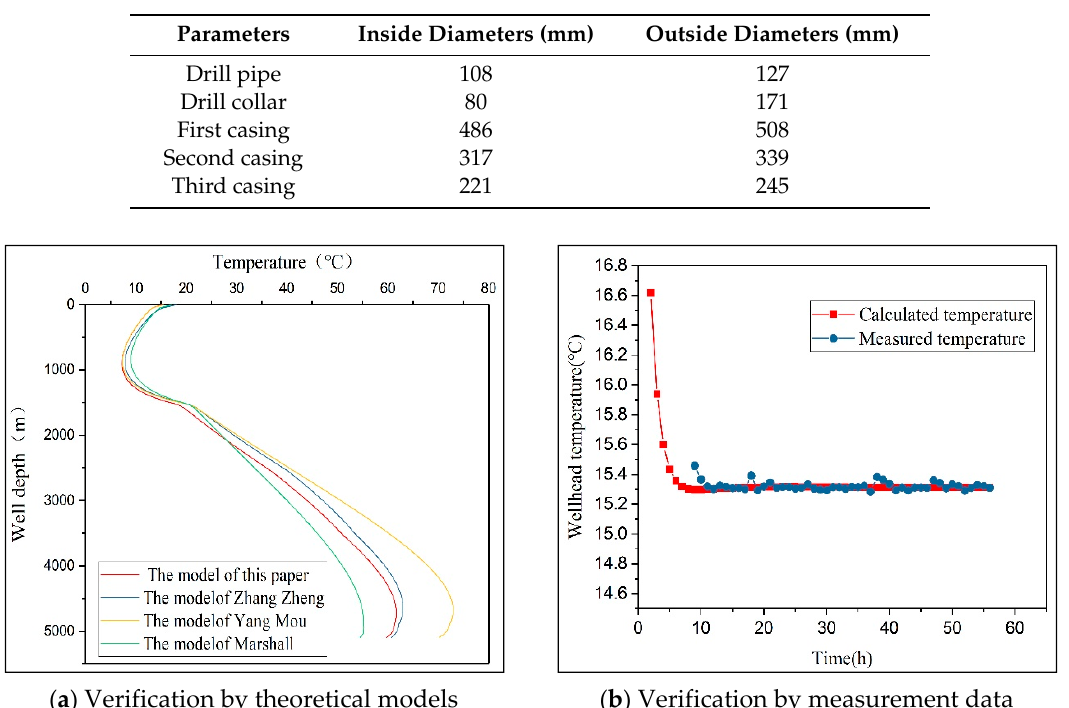
Figure 5. Model verification by using previous models and measurement data.